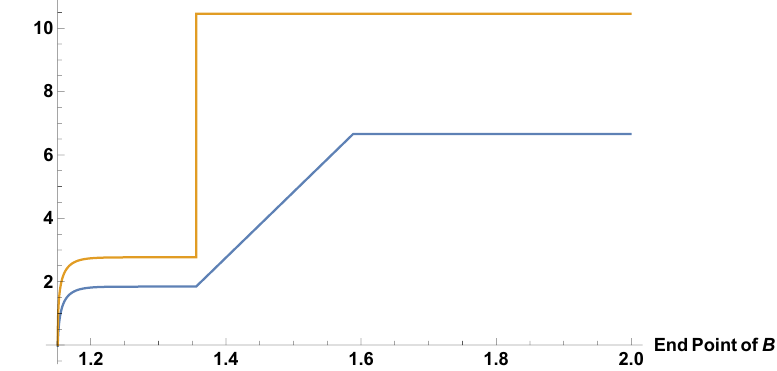
Figure 38 . Plot of correlation measures i.e. reflected entropy (yellow) and mutual information (blue) for two adjacent intervals A and B while the endpoint of the interval B is increased in the bath BCFT 2 s. In the y-axis, the correlation measures are plotted after scaling over the central charge c of the BCFT 2 s. Here r I = 1 , r O = 2 , (cid:15) = . 001 , β = . 1 , c = 500 , t = . 15 , r 1 = 1 . 15 , S bdyb = 875 and S bdya = 850 .